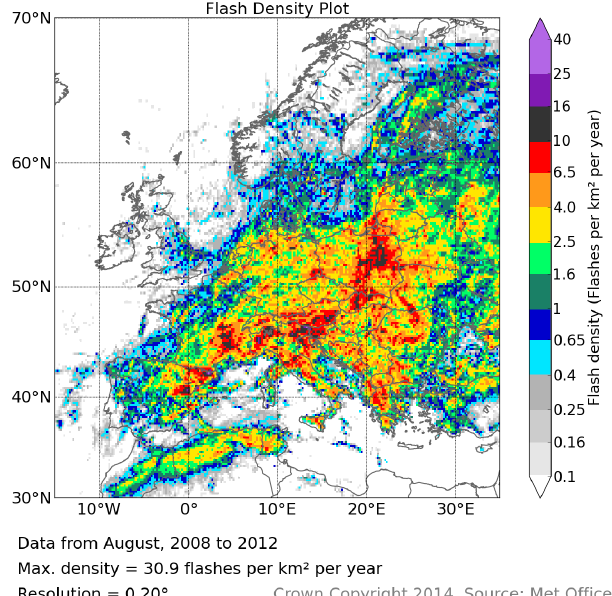
Fig. 12. Detected lightning flash density for August.